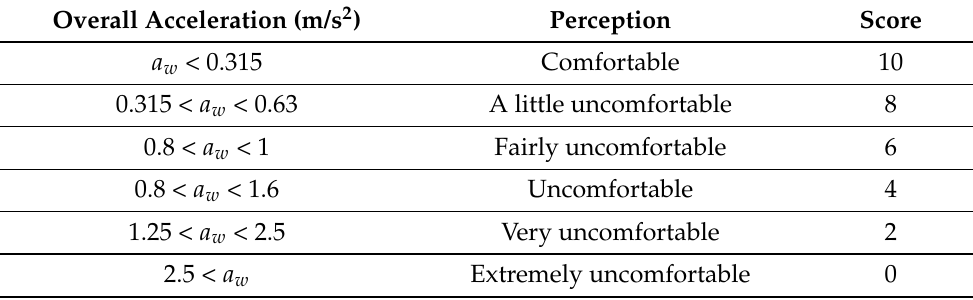
Table 2. Comfort level based on ISO 2631-1 quantification.